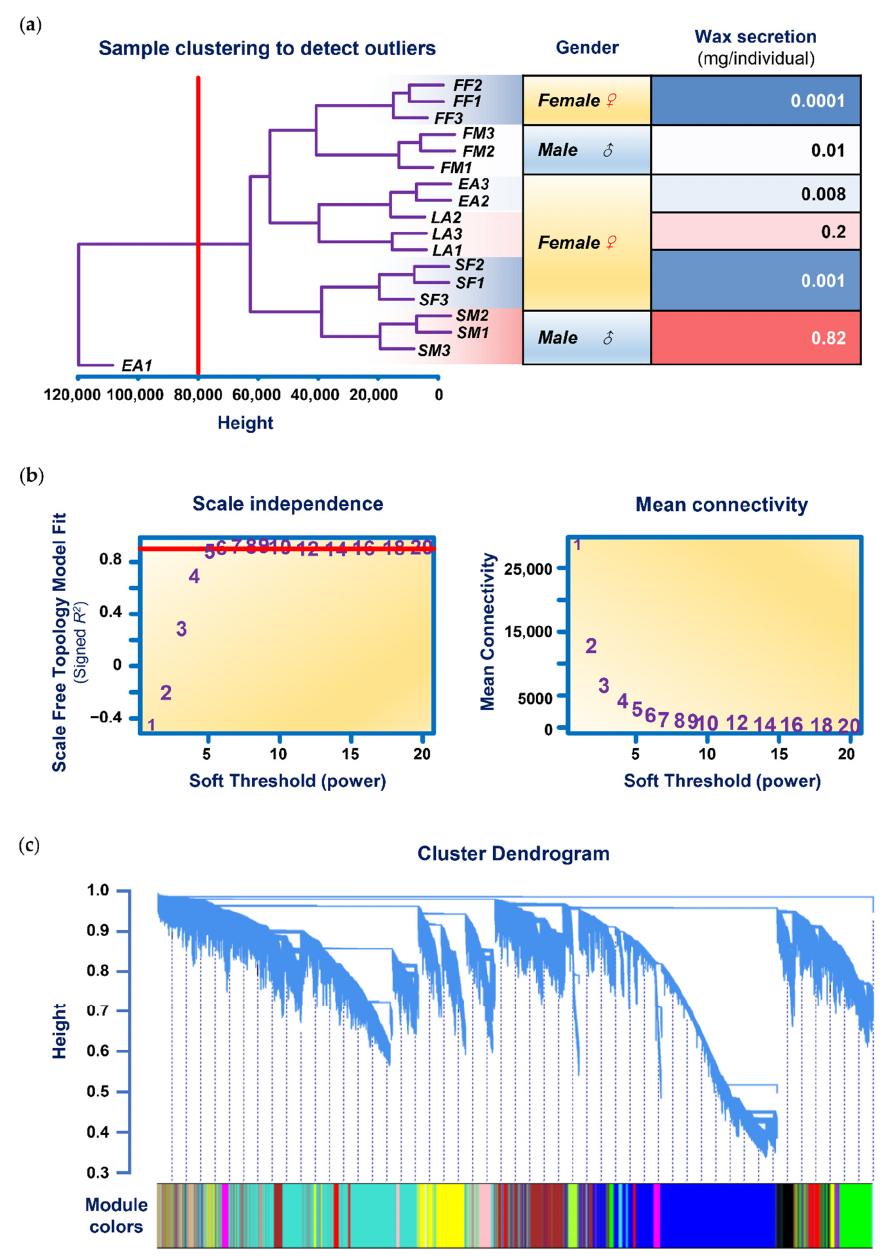
Figure 1. Network analysis of RNA-seq expression data in CWWS insects. ( a ) Clustering dendrogram of samples based on their Euclidean distance. FM , SM , FF , SF , EA, and LA in the figure, respectively, represent first-instar male, second-instar male, first-instar female, second-instar female, early female adult, and late female adult. The following numbers 1, 2, and 3 represent the three biological repetitions of the sample. The red vertical division line at the abscissa 80,000 in the figure indicates that the data corresponding to the abnormal sample EA1 can be deleted by setting the parameter to 80,000 when using the cutreeStatic() function during data preprocessing. ( b ) Analysis of network topology for various soft-thresholding powers. The left panel shows the scale-free fit index ( y -axis) as a function of the soft-thresholding power ( x -axis). The number crossed by the red horizontal line (“5” in the figure) is the lowest power that the scale-free topology fitting index curve flattens when it reaches a high value. The right panel displays the mean connectivity (degree, y -axis) as a function of the soft-thresholding power ( x -axis). ( c ) Clustering dendrogram of genes, with dissimilarity based on the topological overlap, together with assigned module